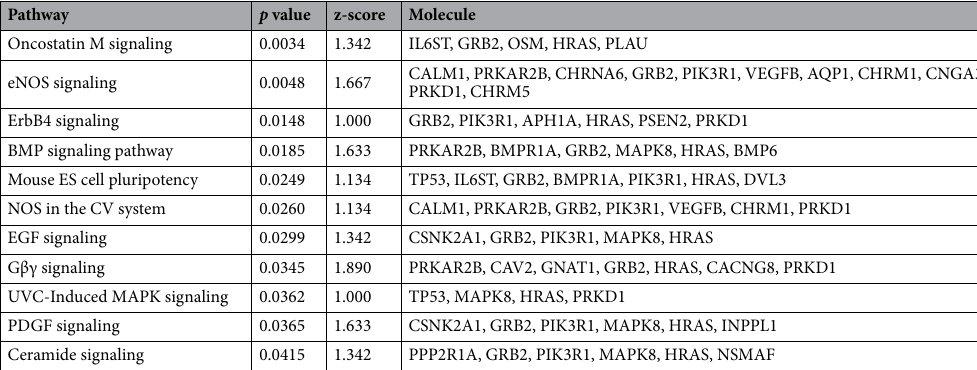
Table 2. Pathways upregulated in the shorter survival cohort. ES cell embryonic stem cell, NOS nitric oxide synthase, CV